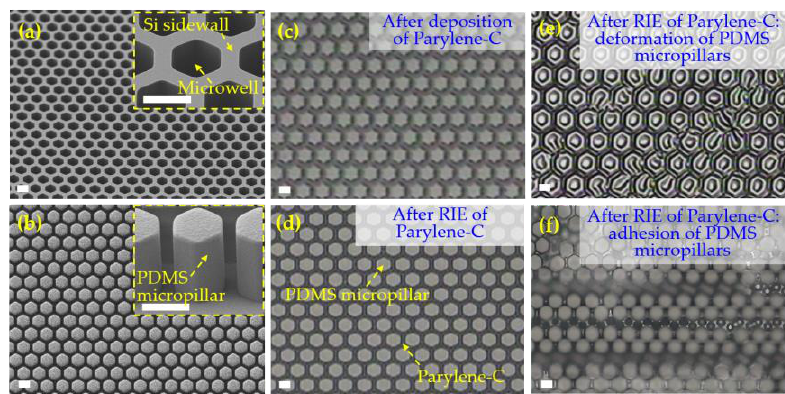
Figure 5. Fabrication results of the Parylene-C molding process with the PDMS template. ( a ) Silicon microwell array prepared via photolithography-based micropatterning and DRIE; ( b ) micropillar